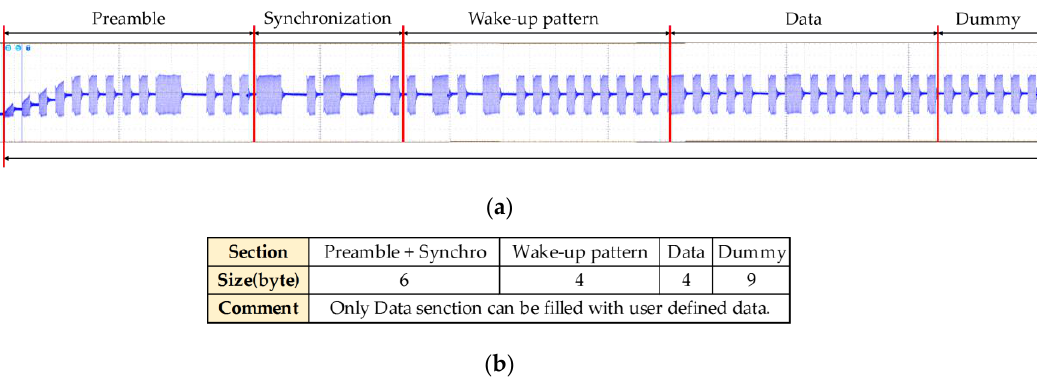
Figure 3. Protocol of LF wireless communication in Pet-Bot system. ( a ) LF signal wave; ( b ) message format for LF wireless communication.